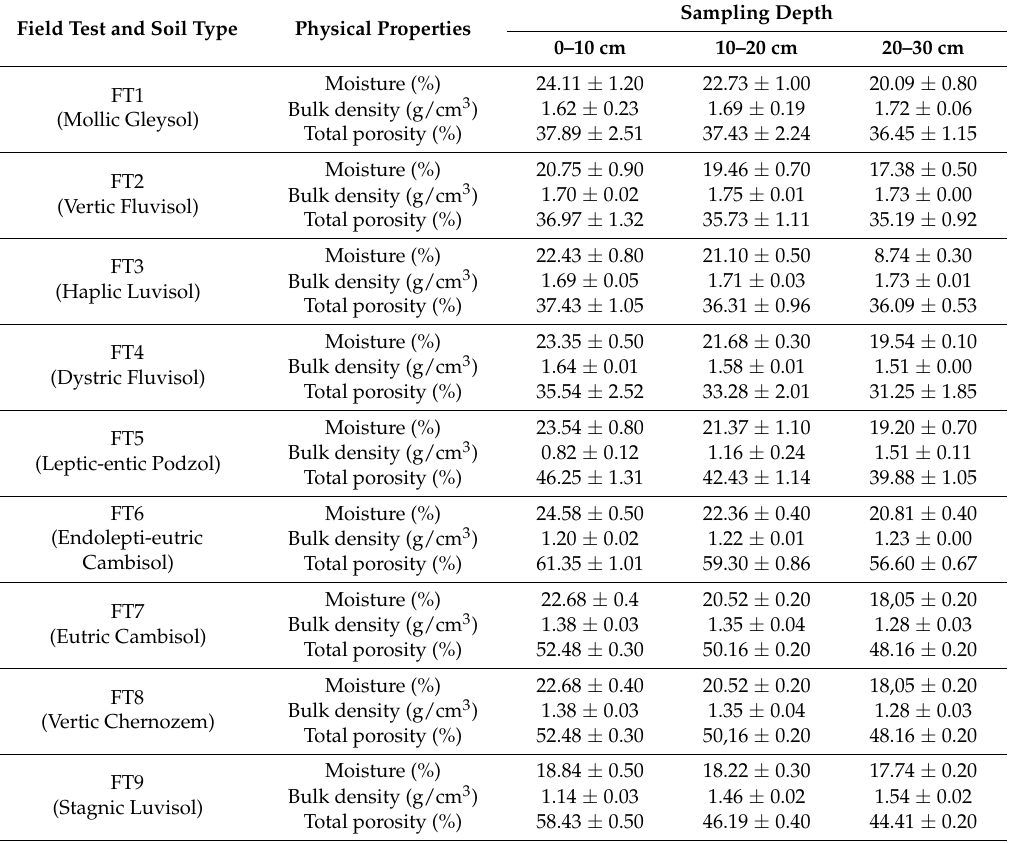
Table 2. Basic physical characteristics of the soils in the field